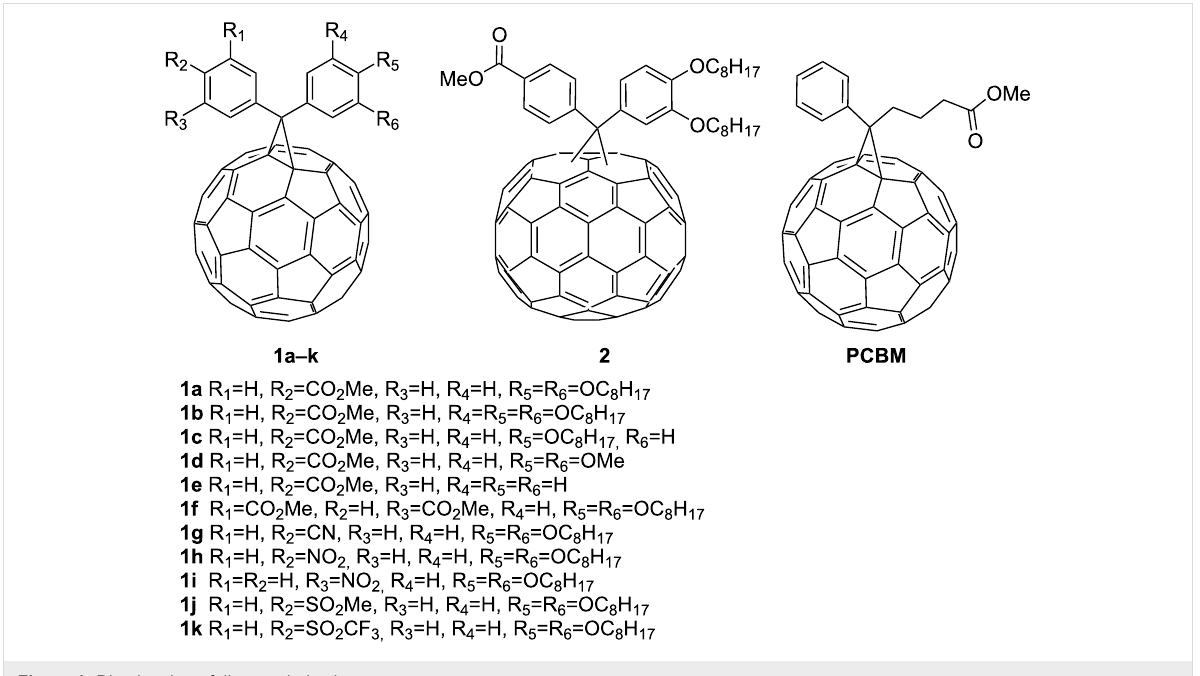
Figure 1: Diarylmethanofullerene